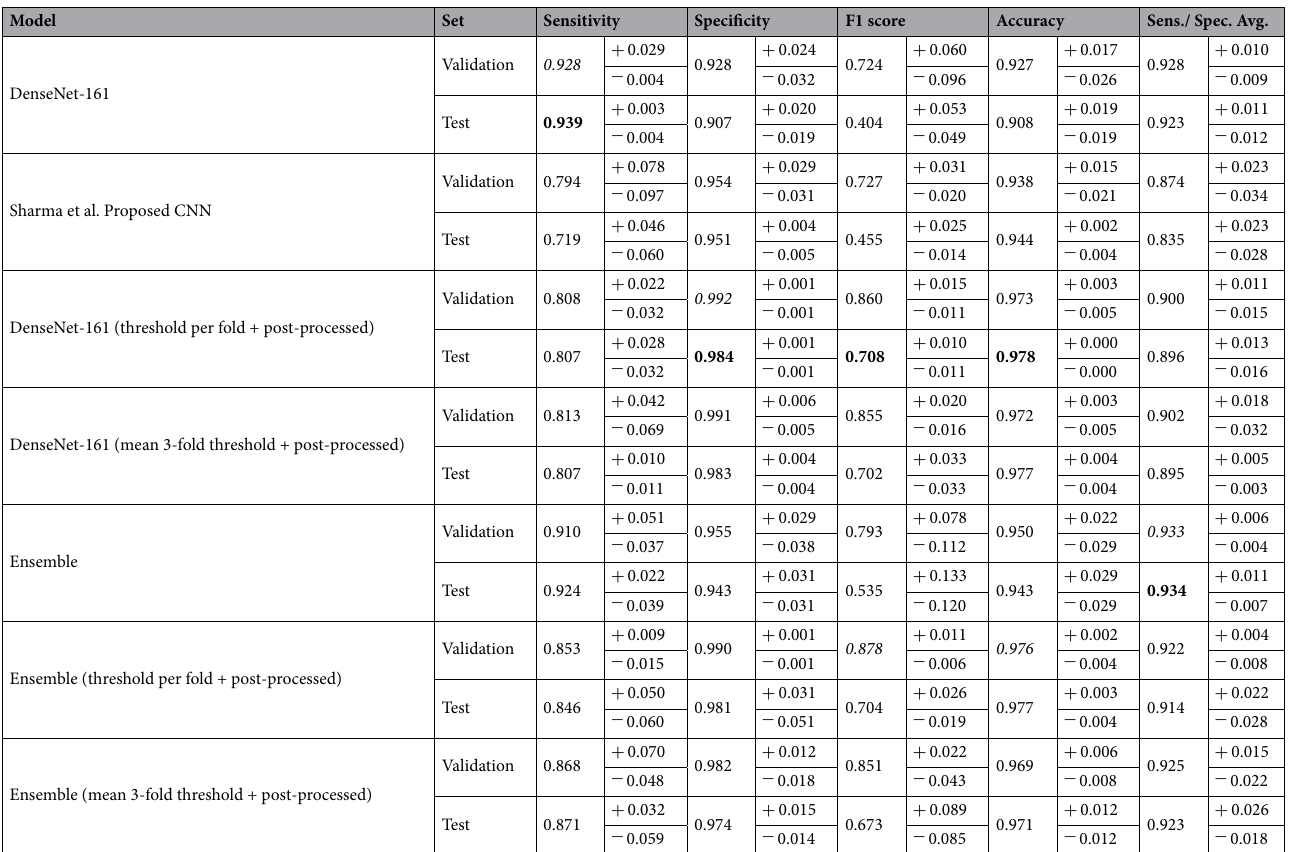
Table 2. 3-fold averaged results after applying optimal thresholds and the single tile removal post-processing to the DenseNet-161, Sharma et al’s 22 proposed CNN and ensemble models, for the validation and test sets. Presented in this table are the mean sensitivity, specificity and f1-scores averaged across all three folds. ”Threshold per fold + post-processed” is where optimal thresholds derived from three-way cross-validation followed by single tile removal were applied to all validation folds and the hold-out test set. ”Mean threshold + post-processed” is where the optimal thresholds for each fold have been averaged and then applied to each folds validation and hold-out test set. The highest score for a certain metric is highlighted in bold for the test set, whereas it is italic for the validation set. Plus/minus values shows the mean subtracted from the highest and lowest results from the 3-fold experiments, for each